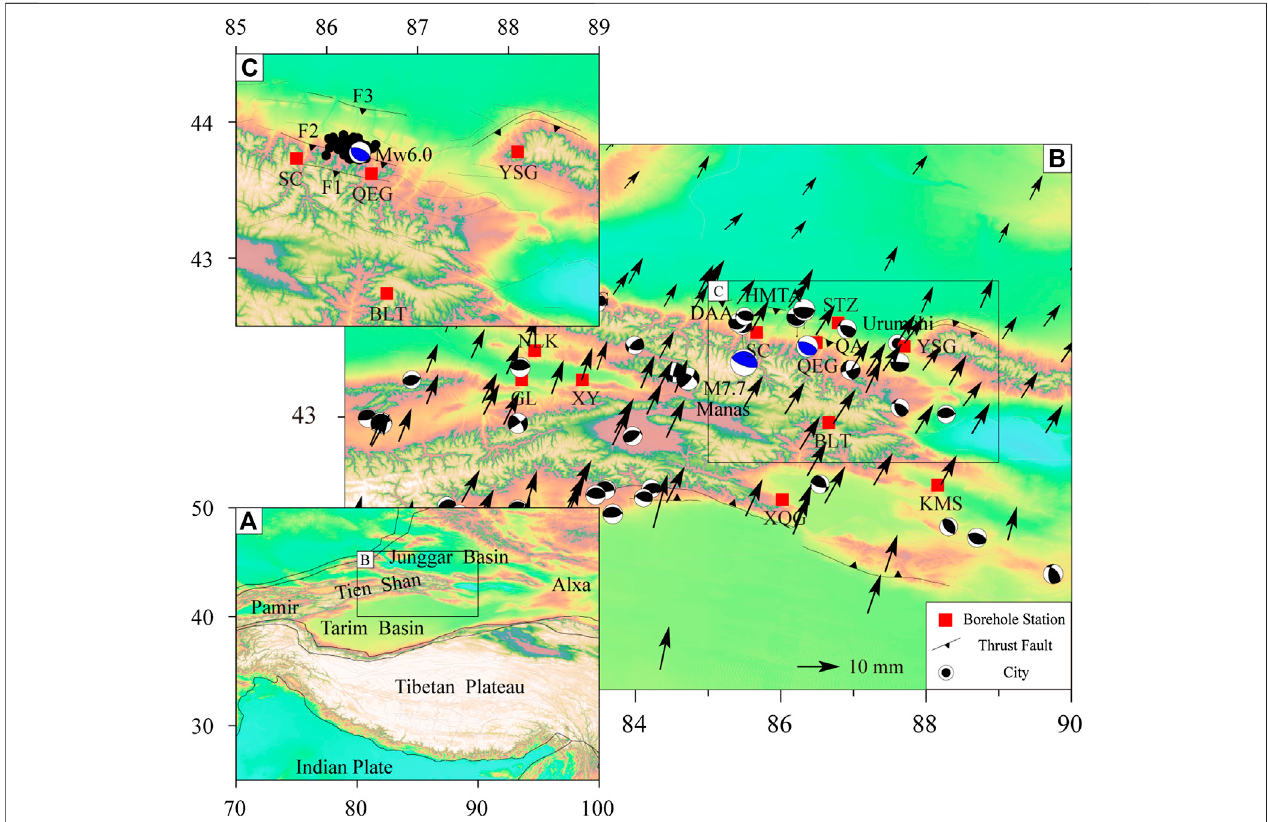
FIGURE1| Tectonicsettingandboreholestationlocations.Structuralfeatures:HMTA,Horgos-Manas-TuguluAnticline;DAA,Dushanzi-AnjihaiAnticline;QA,Qigu Anticline. F1. Yamata fault; F2, Junggar southern margin fault; F3, Horgos-Manas-Tugulu fault. Borehole stations: BLT, Baluntai; QEG, Queergou; SC, Shichang; YSG, Yushugou.GPSvelocities arerelativetothe stable Eurasia plate (Wang and Shen, 2020). Theblack beach ballsshow the historicM ≥ 5.0 earthquakes since 1976 (Data Source: Global CMT). The black circles represent the relocated aftershock of the Mw 6.0 Hutubi earthquake.